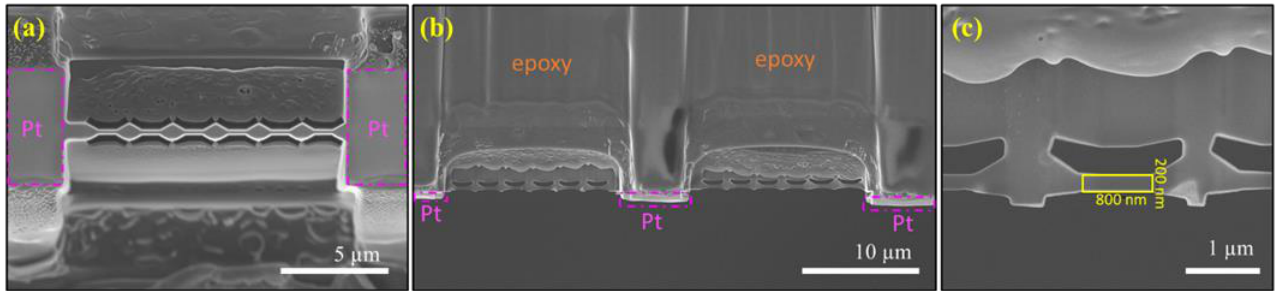
Figure 1. SEM images of dual-clipped cantilever fabricated with FIB; ( a ) top view; ( b ) side view series of beams. Protective Pt layer is deposited on the surface of the epoxy; ( c ) side view (the specimen is marked by yellow rectangular), length = 800 nm; width = 200 nm; thickness = 200 nm.